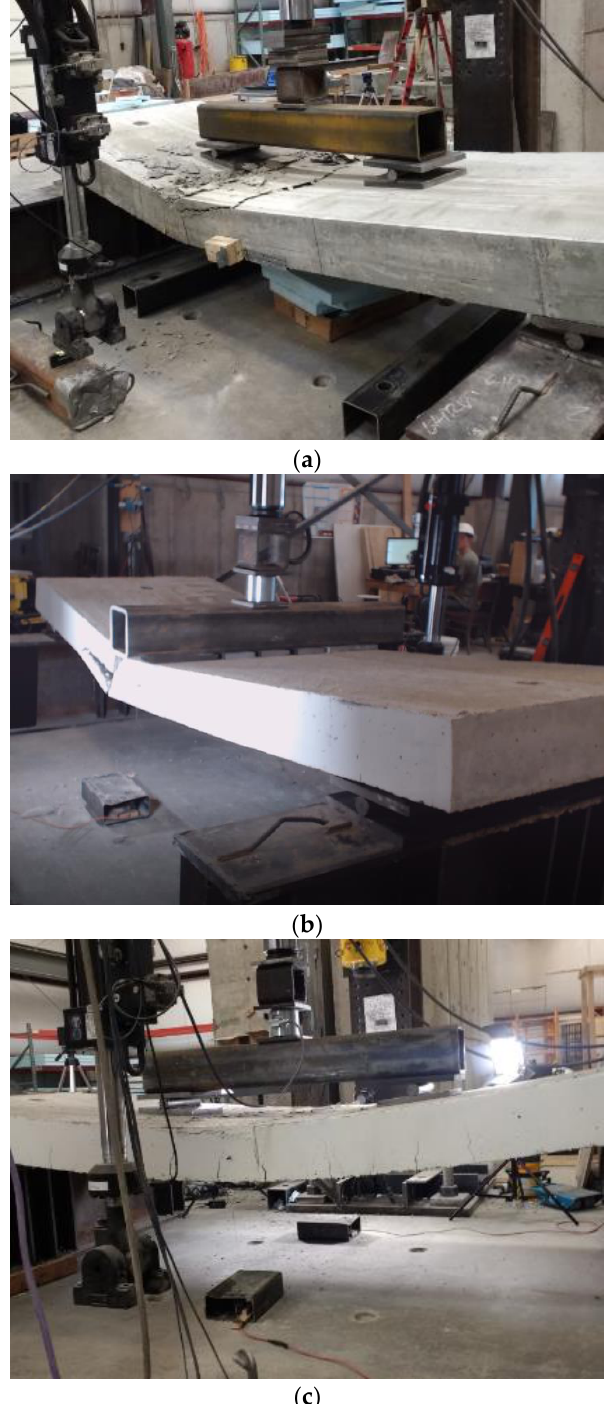
Figure 6. Failure mode of specimens tested under static load ( a ) steel reinforced deck, ( b ) GFRP reinforced deck, and ( c ) Hybrid reinforced deck.